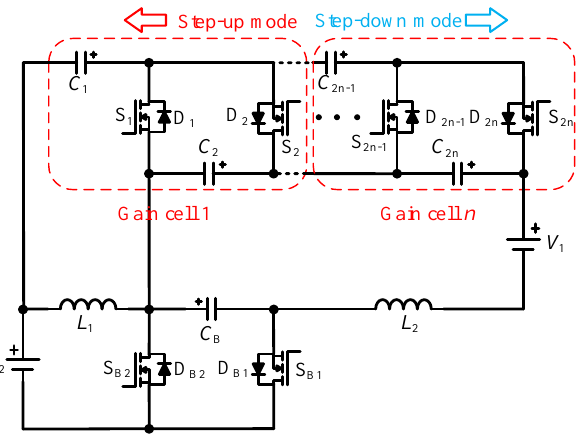
Figure 1. Basic bidirectional Cuk converter.